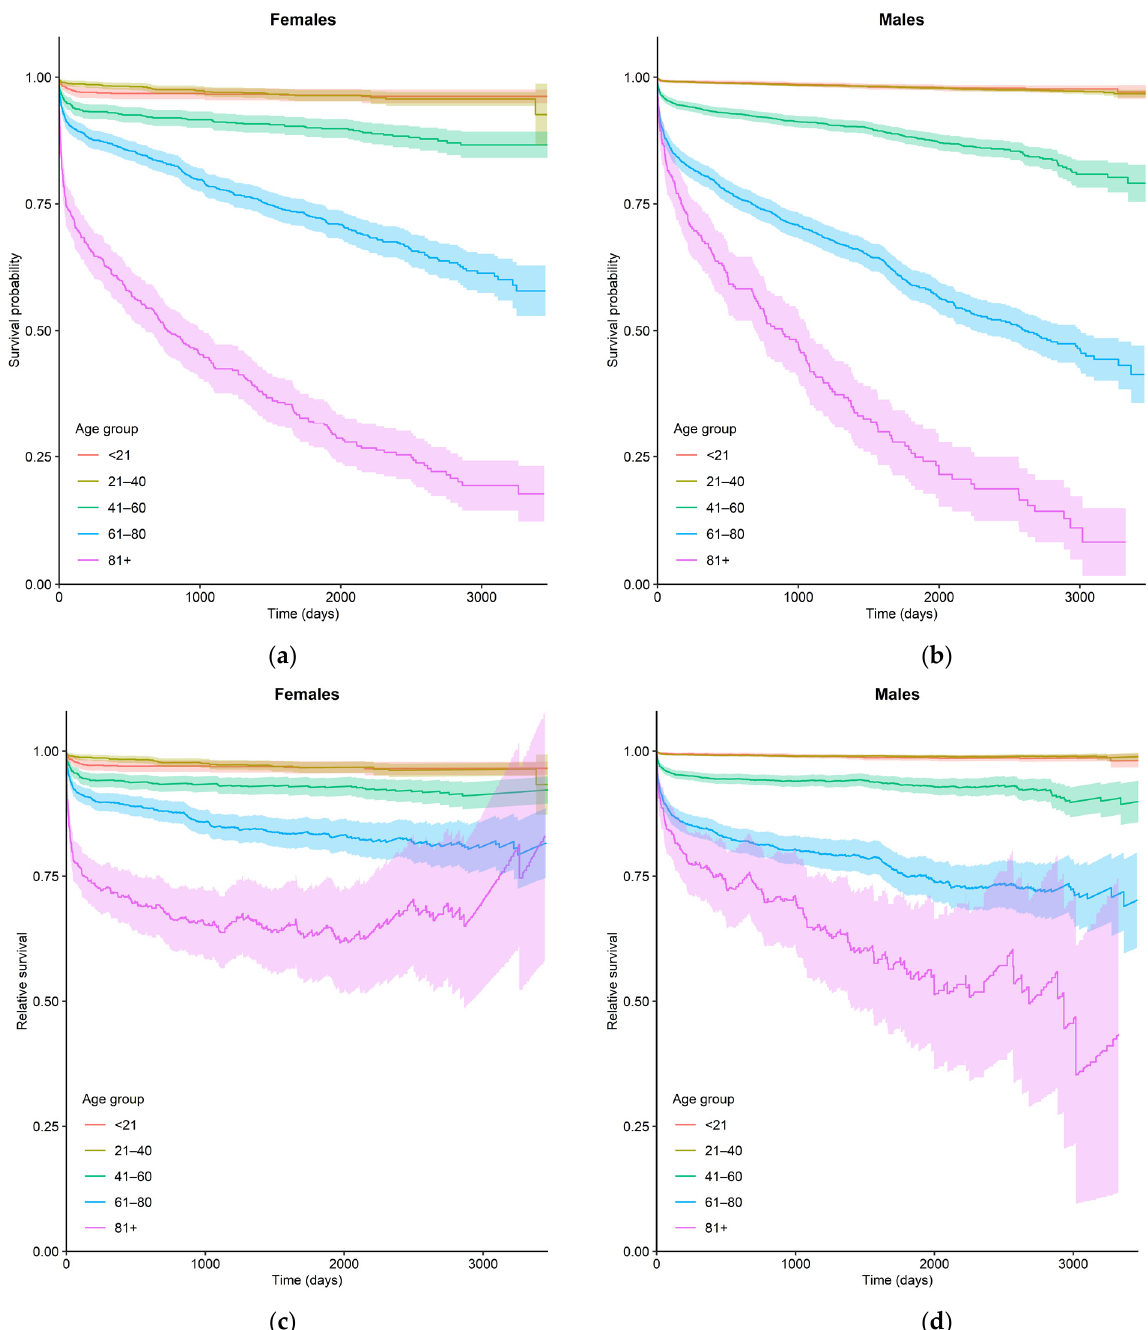
Figure 3. Observed ( a,b ) and relative ( c,d ) ten-year survival rates of patients hospitalized for myocarditis in relation to sex and age.